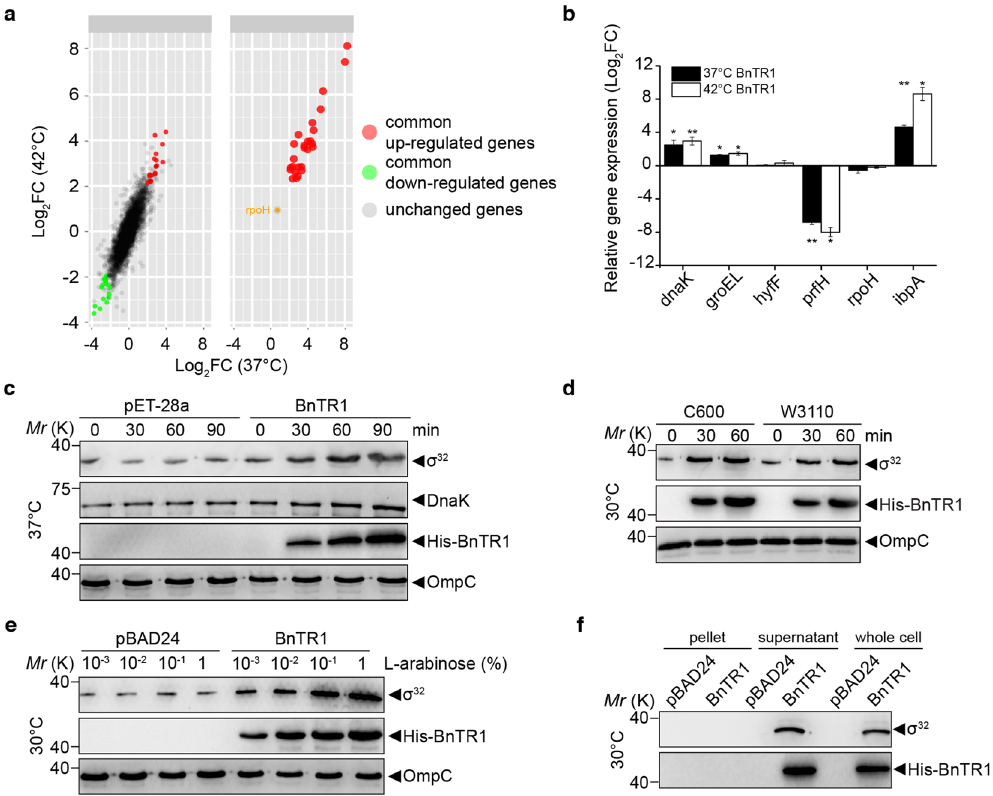
Figure 2. The σ 32 level is increased during the expression of BnTR1. ( a ) Distribution of σ 32 regulons among the common DEGs (right panel). The expression level of rpoH measured by microarray is denoted as an orange dot. ( b ) Validation of microarray data by q RT-PCR and two-tailed Student’s t -test was used for the comparison ( * p -value < 0.05 and ** p -value < 0.001). Six genes were selected, including three heat shock genes ( dnaK , groEL , and ipbA ), one down-regulated DEG ( prfH ), and two genes without significance ( hyfF and rpoH ). ( c ) Whole-cell extracts from pET and pET-BnTR1 cells cultured at 37 °C with 0.1 mM IPTG were analysed using Western blotting (probed with anti-DnaK, anti- σ 32 , and anti-His for BnTR1). ( d ) Wild-type E . coli W3110 and C600 cells harbouring the pBAD24 empty vector or pBAD-BnTR1 were grown at 30 °C with 0.1% L-arabinose. Whole-cell extracts taken at the indicated time were loaded and probed with anti- σ 32 and anti-His for BnTR1. (e) Whole-cell extracts were from E . coli C600 cells induced with different concentration of L-arabinose for 30 min at 30 °C. Immunoblots were shown and probed with antibodies indicated. ( f ) Western blotting (probed with anti- σ 32 and anti-His for BnTR1) of whole cell, supernatant, and pellet proteins that were extracted as described in ( d ). OmpC was detected in parallel by anti-OmpC and used as a loading control in (c , d and e) . The data are presented as means ± s.d. of three independent experiments ( b ). Full-length blots are presented in Supplementary Figure